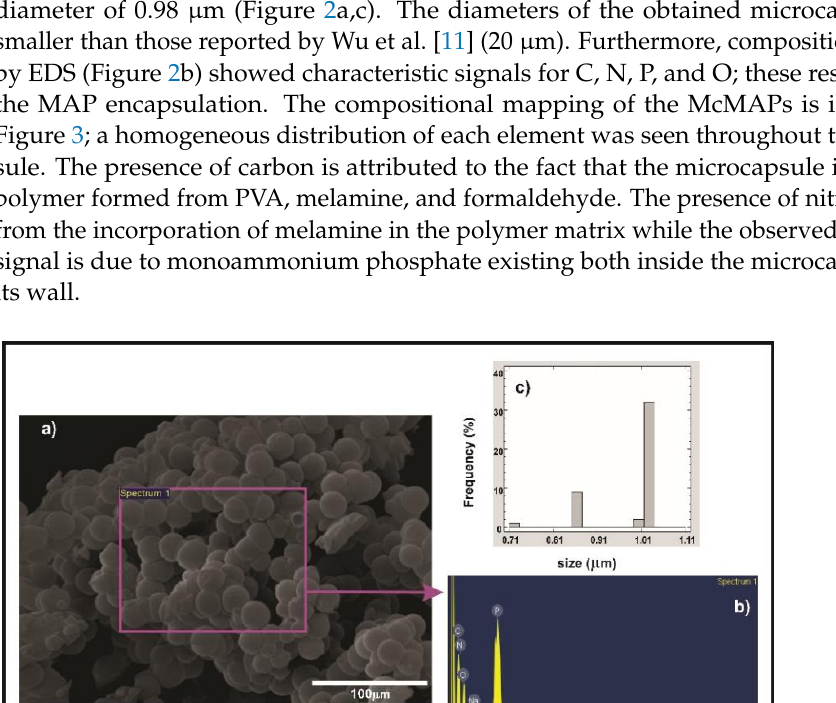
Figure 3. ( a ) McMAP EDS mapping image and distributions of the various elements that make up the microcapsules: ( b ) carbon (C), ( c ) phosphorus (P), ( d ) nitrogen (N), and ( e ) oxygen (O). 3.2. Thermogravimetric Analysis (TGA) The thermogravimetric analysis (TGA) curve and Differential Thermogravimetric Analysis (DTG) for the McMAPs are shown in Figure 4 and the decomposition tempera- tures are reported in Table 3. Only 26.51% of the initial mass was retained at 600 °C as revealed in the TGA curve. The observed loss of mass corresponds to the thermal degra- dation of the microcapsules. Upon determining the first derivative DTG of the TGA curve, three clear decomposition processes are identified for McMAP: 40−190, 200−430, and 430−600 °C. The maximum temperatures of each stage are 103.4, 337.2, and 468.2 °C. The first stage of degradation corresponds to the decomposition of PVA and is attributed to the breakdown of ester bonds, the release of non-flammable gases due to the decomposi- tion of melamine, and the evaporation of absorbed water [27,28]. The loss of mass in the second stage is caused by the elimination of NH 3 from the melamine units [29]. The final stage of thermal degradation is a result of MAP decomposition in the microcapsules, which generates phosphoric acid and metaphosphoric acid, followed by their dehydration to form phosphorous oxides (P 4 O 10 ) [28,30].